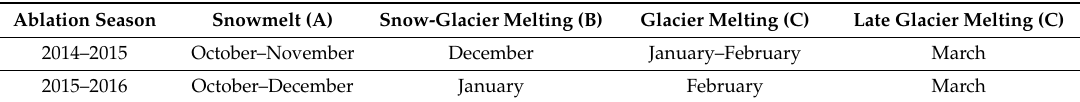
Table 1. Periods in which the ablation season in the Estero Morales can be split, depending on the dominant origin of melting water. The main origin of runoff is split in snowmelt (A), snow and glacier melting (B) and glacier—later glacier melting periods (C).